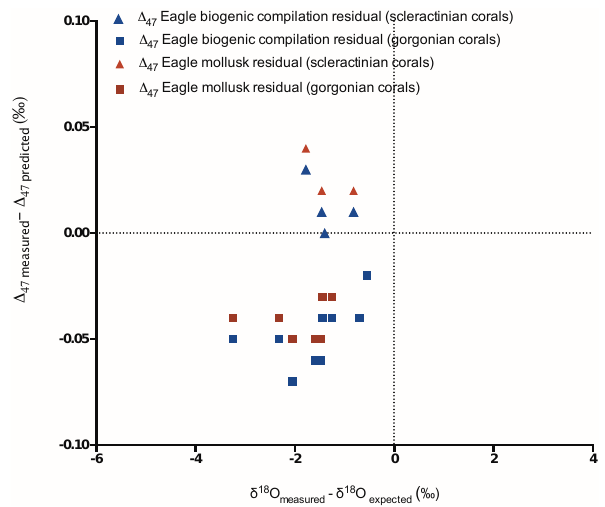
Figure 8. (cid:49) 47 residuals are calculated from average measured (cid:49) 47 values for each coral relative to the biogenic calibrations of Eagle et al. (2013). δ 18 O residuals are calculated from average measured δ 18 O values relative to the calibrations of Kim and O’Neil (1997) and Kim et al. (2007) for calcite and aragonite, respectively.